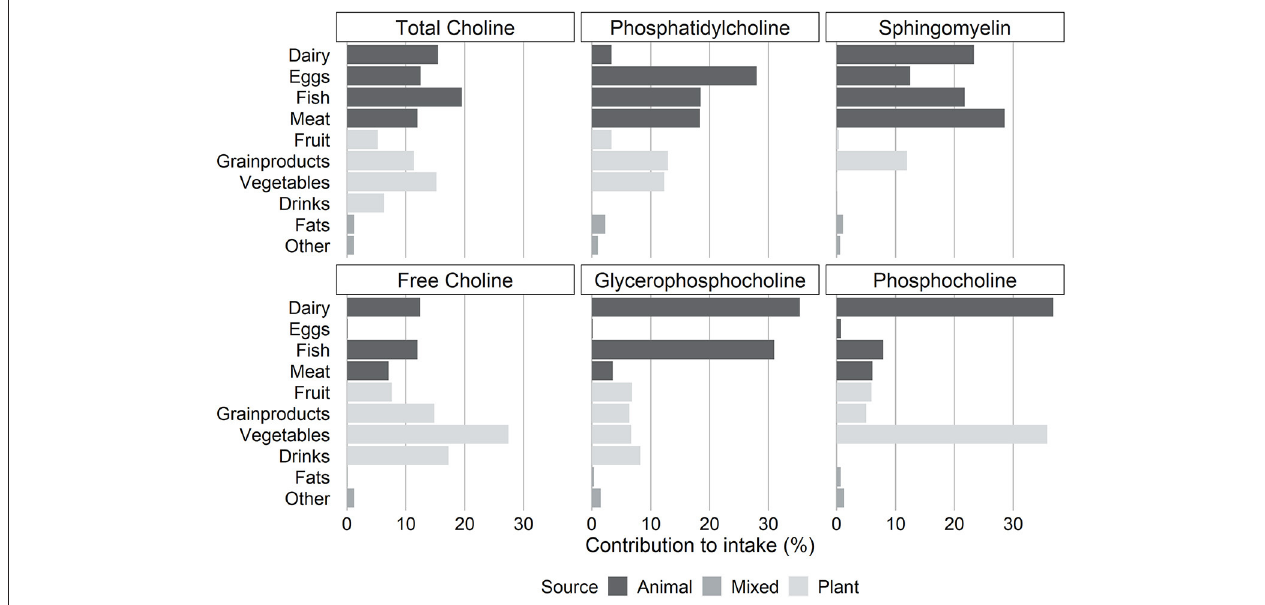
FIGURE 1 | Contribution of food groups to the intake of total choline and individual choline forms.